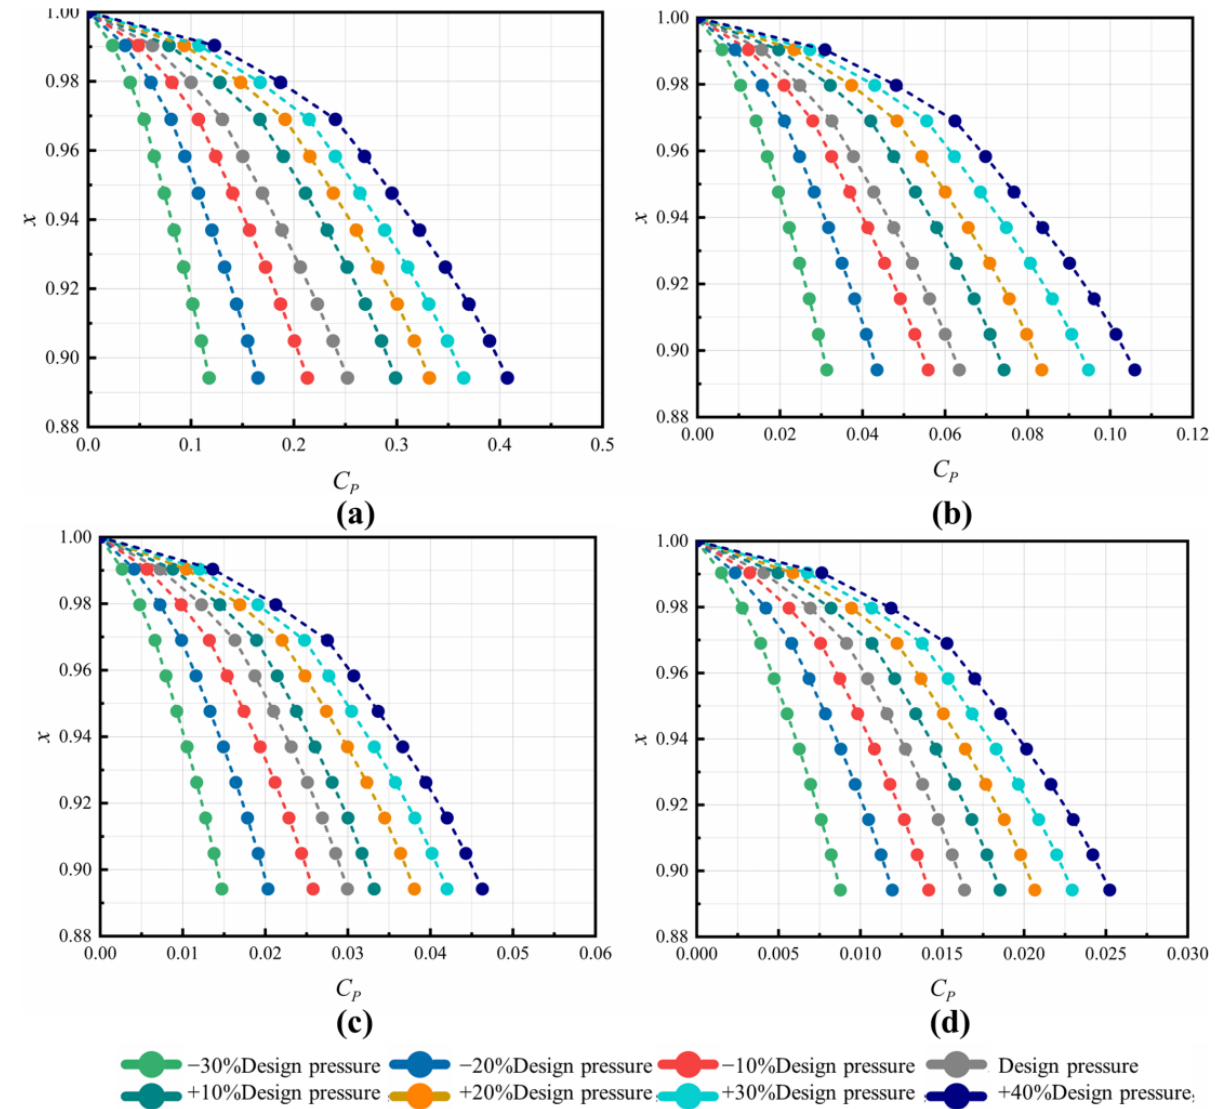
Figure 7. Radial distribution of pressure coefficients in C3 cavity at different Re : ( a ) Re = 2.3793 × 10 5 , ( b ) Re = 4.7586 × 10 5 , ( c ) Re = 7.1379 × 10 5 , and ( d ) Re = 9.5172 × 10 5 .